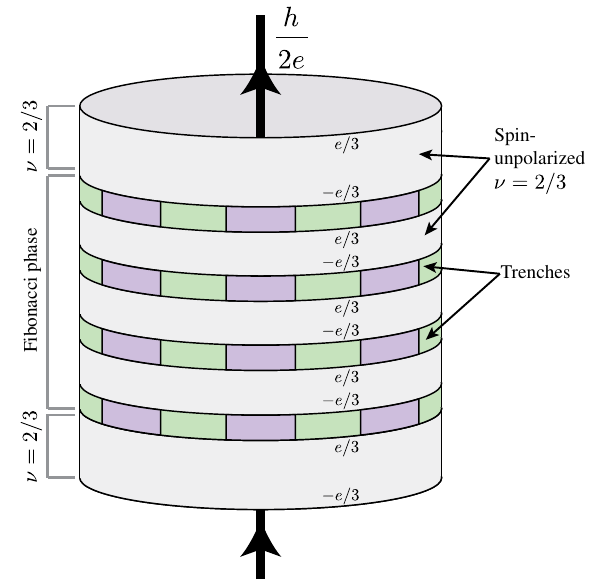
FIG. 9. Cylinder geometry used to deduce the properties of h= 2 e superconducting vortices in the Fibonacci phase. We initially assume that pure ν ¼ 2 = 3 quantum Hall states border the Fibonacci phase from above and below. This results in two types of well-defined boundaries: the Fibonacci phase-to-quan- tum Hall interface, and the quantum Hall-to-vacuum edge. Adiabatically inserting h= 2 e flux through the cylinder (which is topologically equivalent to an h= 2 e vortex in the bulk of a planar Fibonacci phase) pumps charge e= 3 across each quantum Hall region, as shown above. Because the charge difference across the trenches then changes, the upper Fibonacci phase-to- quantum Hall interface binds either a ψ or σ excitation that carries charge 2 e= 3 mod 2 e . The upper quantum Hall-to-vacuum edge, however, binds charge e= 3 so that, in total, the vortex carries only fermion parity. If one shrinks the pure quantum Hall regions so that the two boundaries hybridize, ψ and σ lose their meaning since other sectors mix in. The final conclusion is that an h= 2 e vortex traps either a trivial particle or a Fibonacci anyon depending on nonuniversal details, but does not lead to new quasiparticle